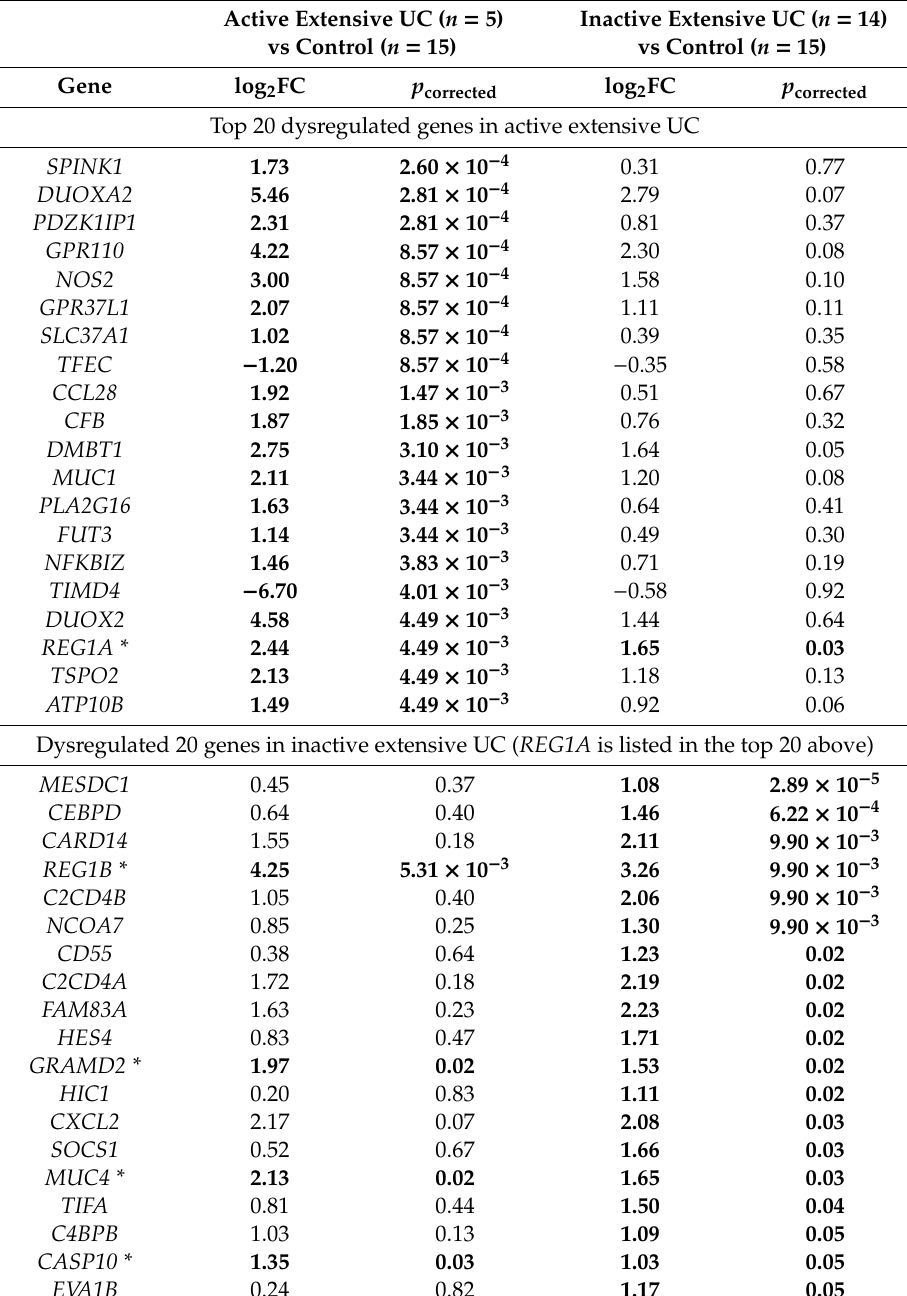
Table 3. Significantly dysregulated genes in the terminal ileum of ulcerative colitis patients with extensive colitis (as maximal disease